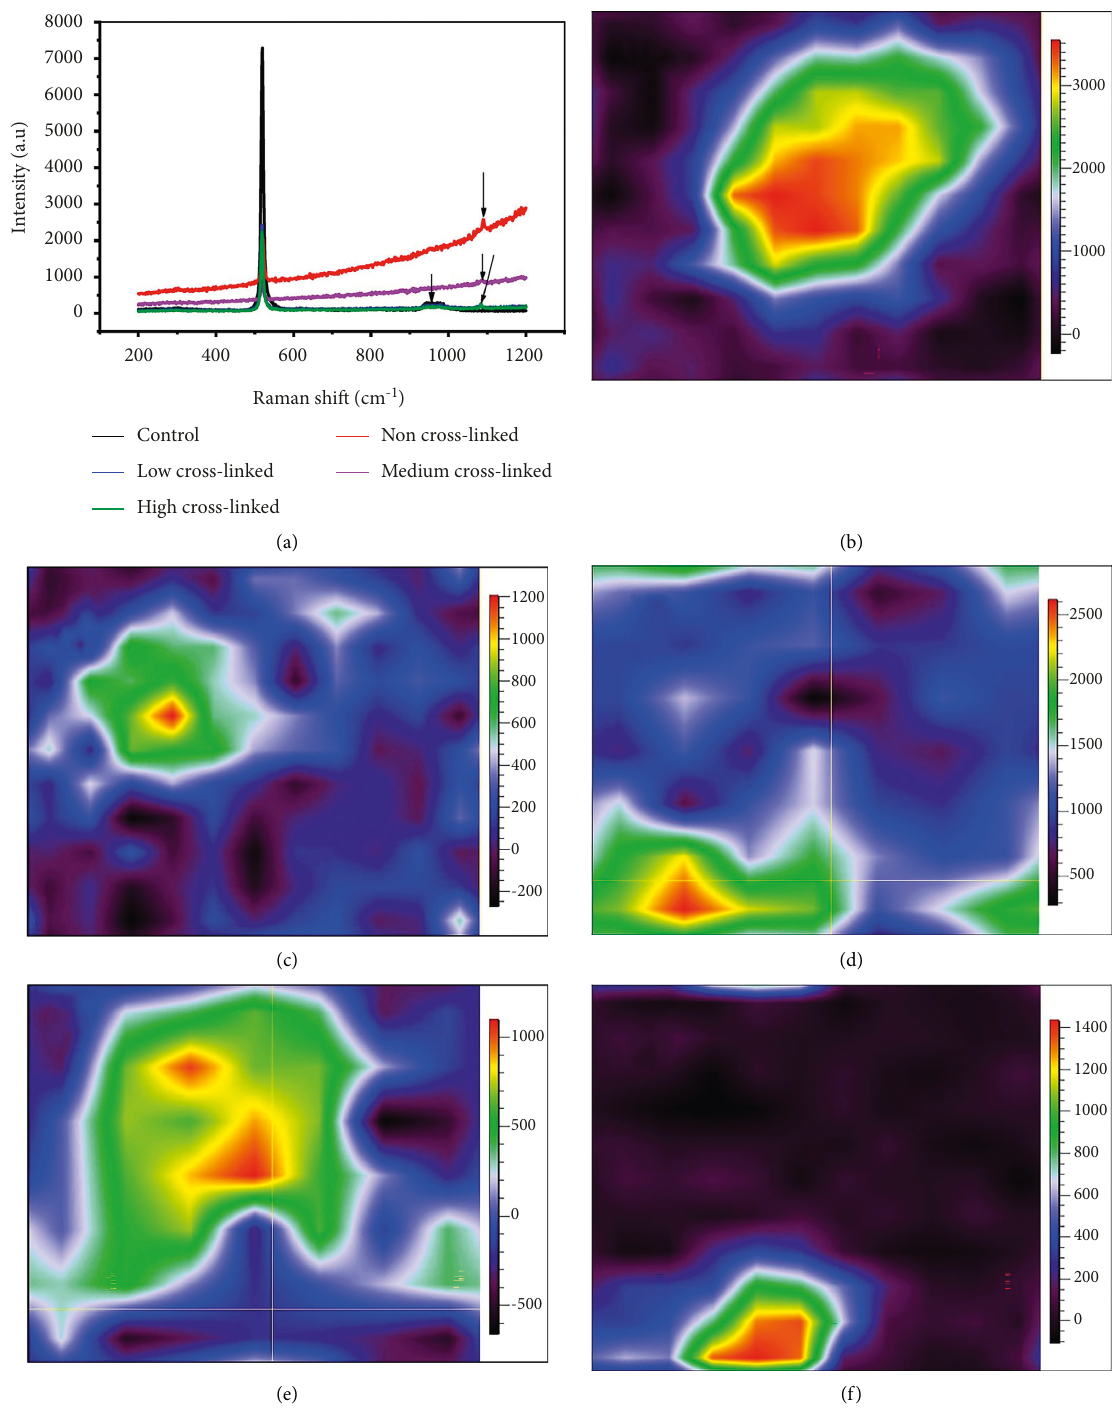
Figure 6: (a) Raman spectrum of all cross-linkages and Raman mapping of (b) noncross-linked (c) low cross-linked, (d) medium cross- linked, and (e) highly cross-linked (PAH/PAMAM) 7.5 -CaCO 3 . (f) PAH/PAMAM) 7.5 -CO 32 − (control) (dimension of mapping area � 5 μ m × 5 μ